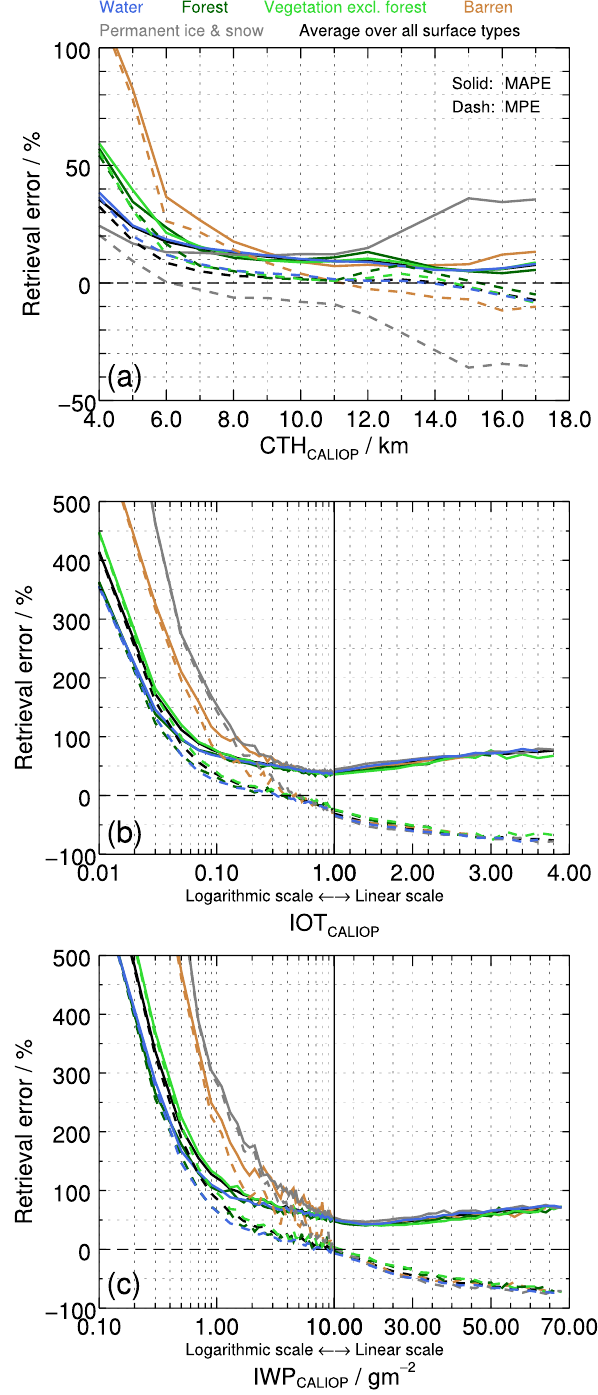
Figure 4. The MAPE (solid) and MPE (dash) of the CTH CiPS (a) , IOT CiPS (b) and IWP CiPS (c) retrievals as functions of the corre- sponding reference retrievals from CALIOP. The retrieval errors of CiPS are presented for the five surface type classes introduced in Sect.